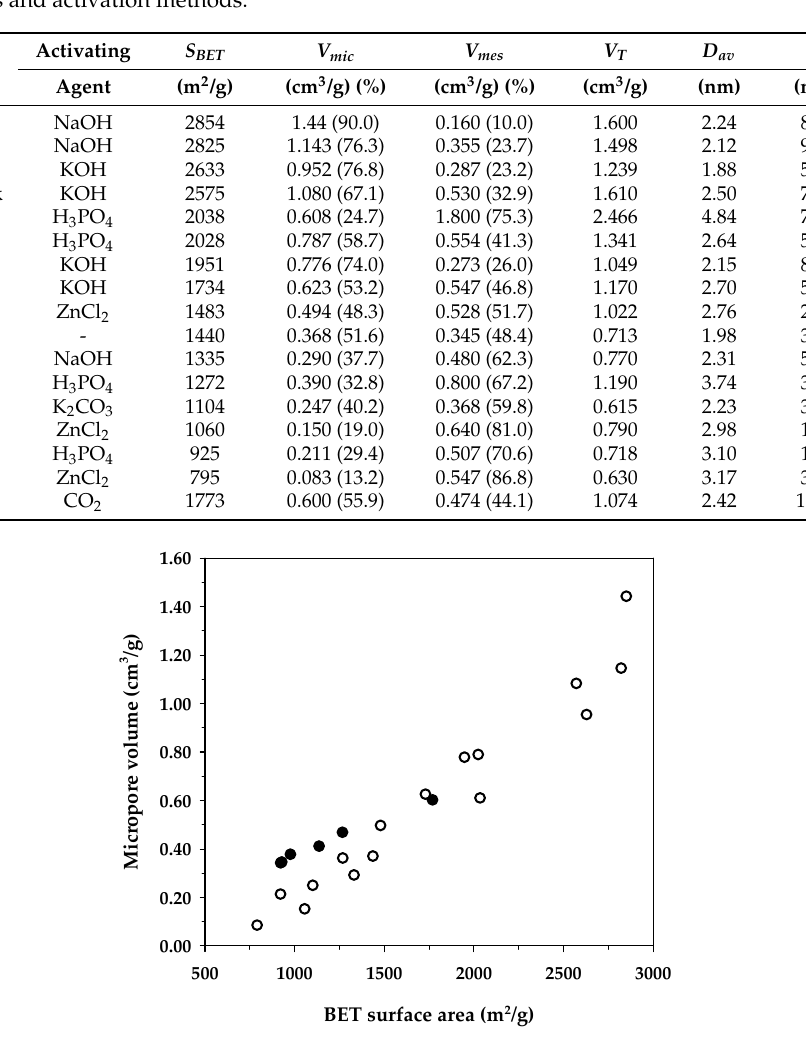
Figure 7. Correlation between the specific surface area and the maximum adsorption capacity of methylene blue from the data in Table 8. The black circles represent the activated carbons in the present study, whereas the white circles belong to previous investigations.